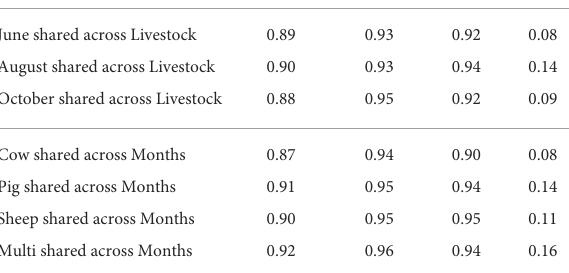
TABLE 1 Soil physical and chemical characteristics of integrated bulk soil samples for each grazing treatment in October. Variable Cow Pig Sheep Multi